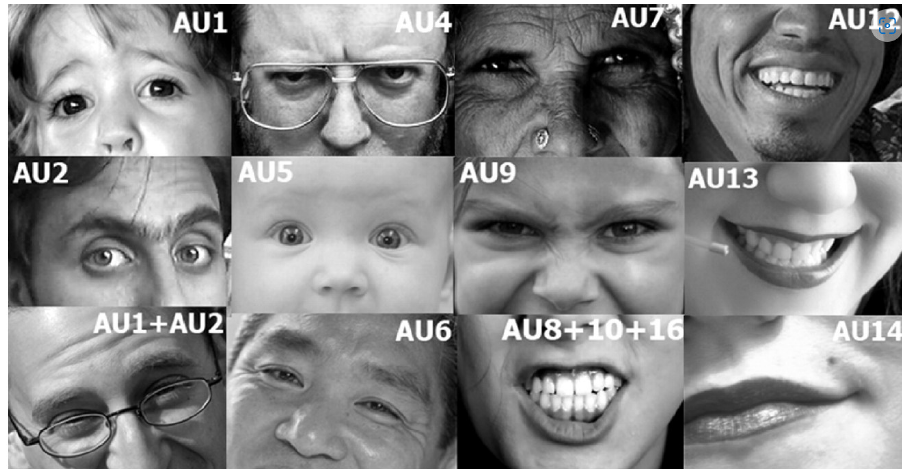
Figure 4. Action units Figure 4. Action Table 3. Action units.